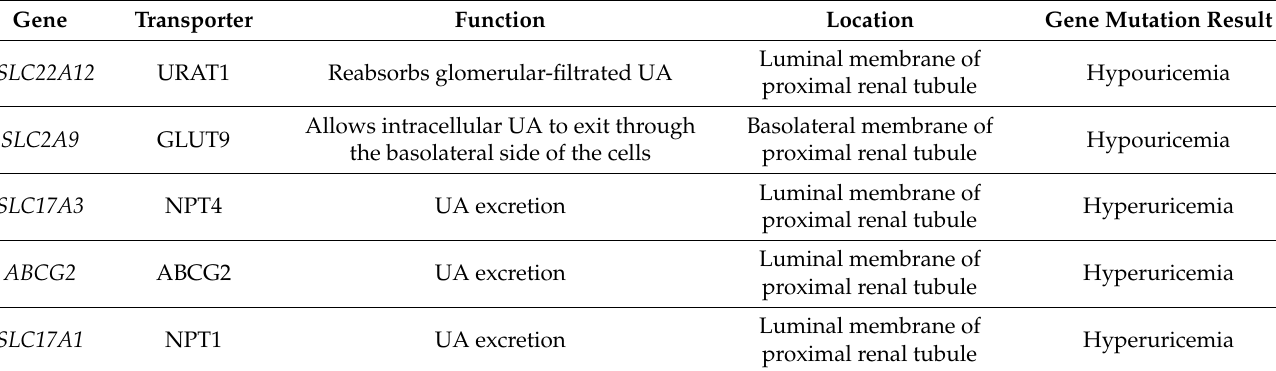
Table 1. Gene mutation results by renal urate